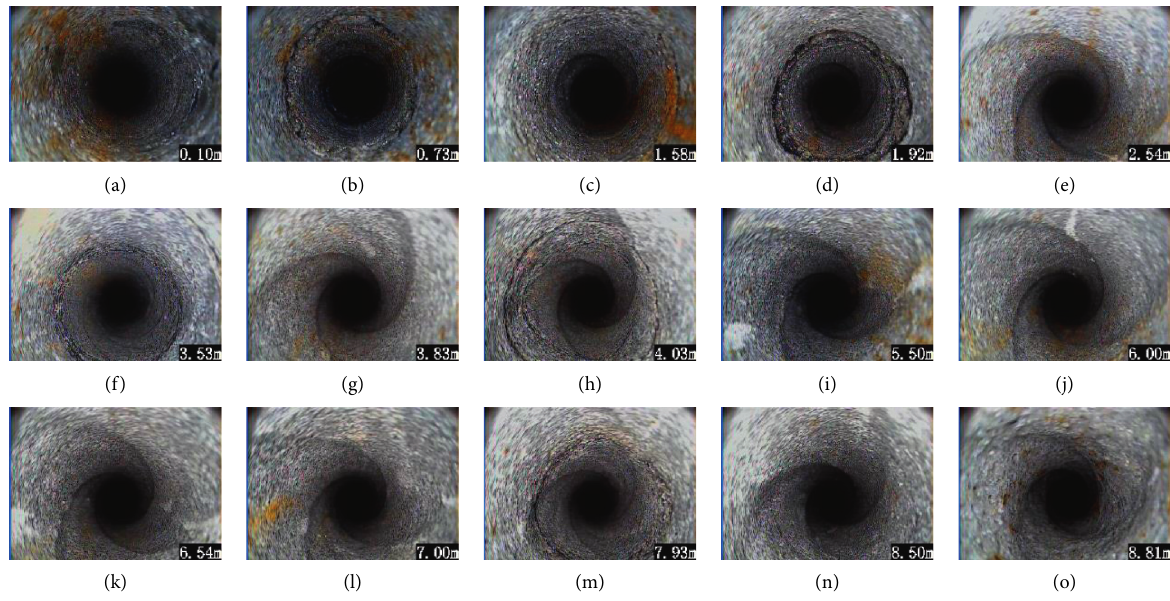
Figure 15: Internal roof structure after backfilling. (a) 0.10 m. (b) 0.73 m. (c) 1.58 m. (d) 1.92 m. (e) 2.54 m. (f) 3.53 m. (g) 3.83 m. (h) 4.03 m. (i) 5.50 m. (j) 6.00 m. (k) 6.54 m. (l) 7.00 m. (m) 7.93 m. (n) 8.50 m. (o) 8.81